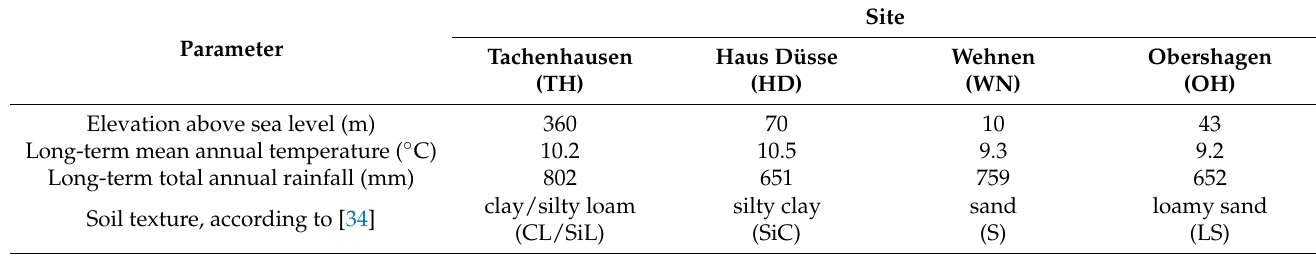
Table 2. Factor levels of the field